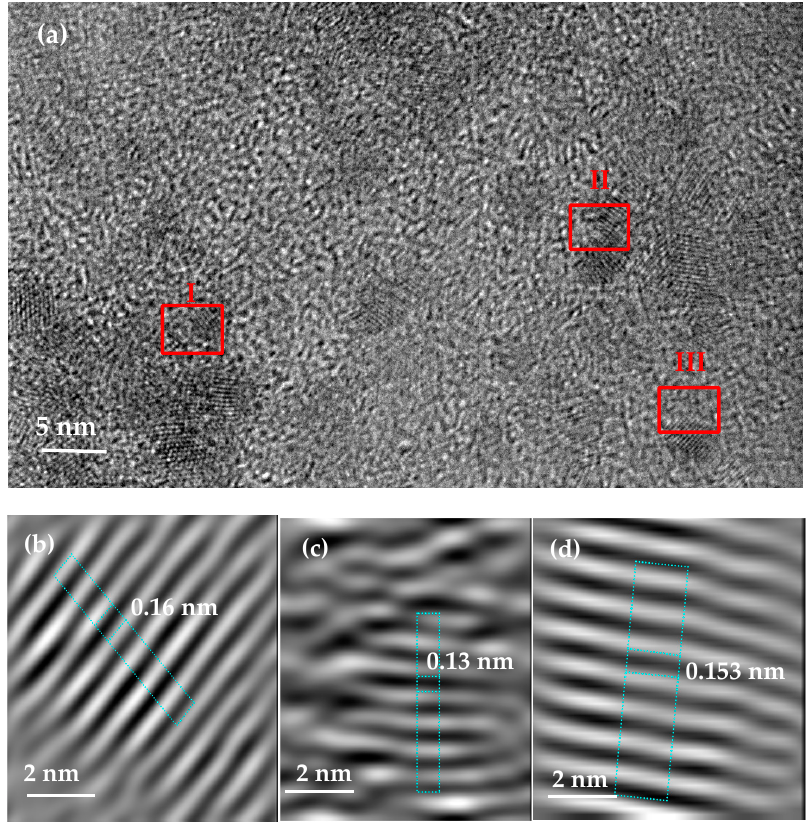
Figure 2. Field emission high resolution transmission electron microscopy (FE-HRTEM). ( a ) Zr (x) Ni (y) nanocatalyst, ( b ) the lattice image of zone I; ( c ) the lattice image of zone II; ( d ) the lattice image of zone